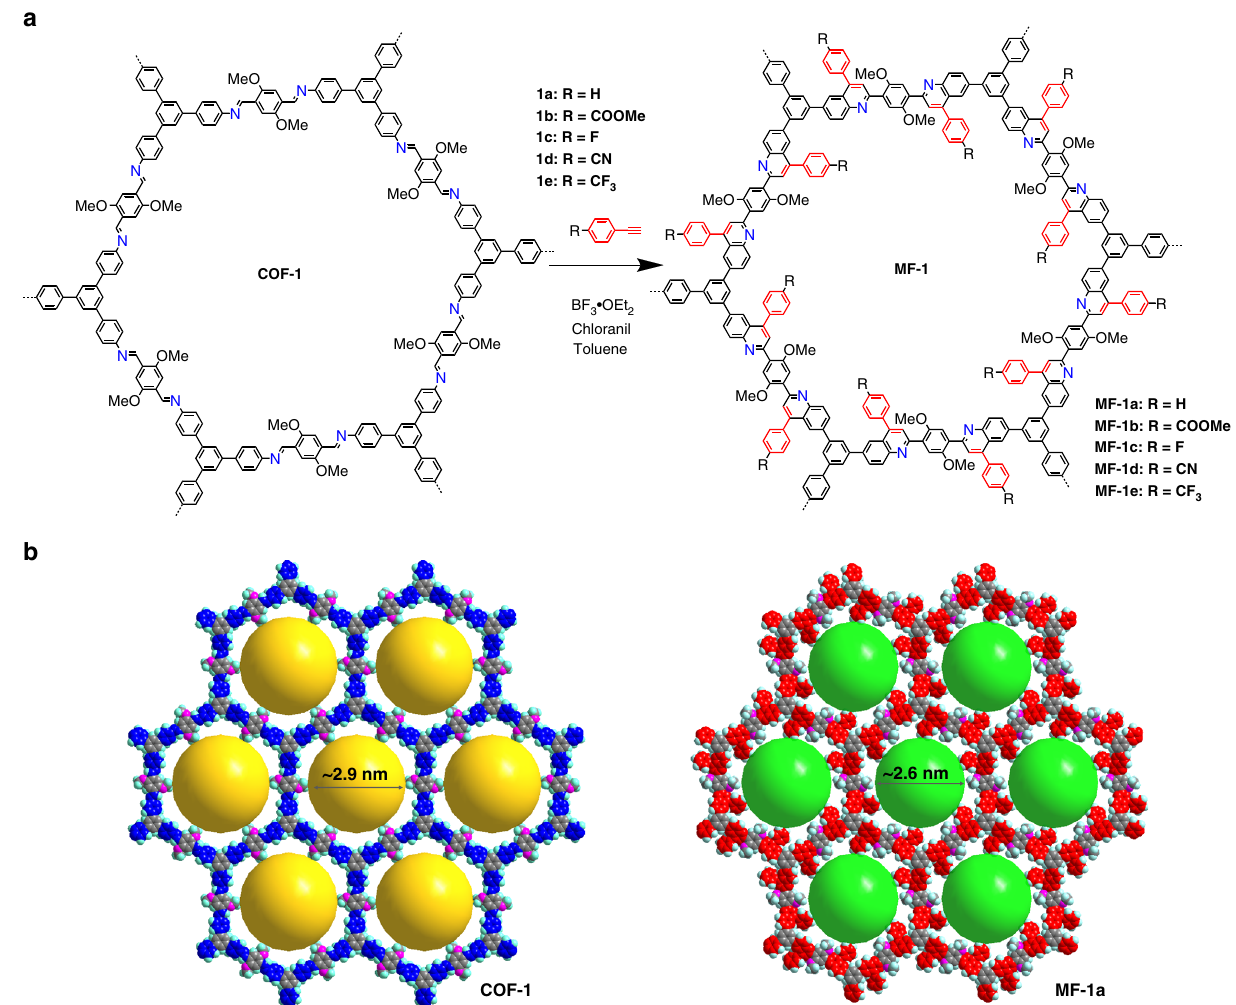
Fig. 1 Post-synthetic modi fi cation of COFs via aza-DA reaction. a The reaction scheme showing the transformation of one lattice unit of COF-1 into MF-1a- e. b The simulated modeled structure showing the extended frameworks of COF-1 and MF-1a. The yellow and cyan sphere indicate pore diameter of ~2.9 and ~2.6 nm. Note that the illustrated structure of MF-1 contains fully converted quinolines and does not represent the actual degree of